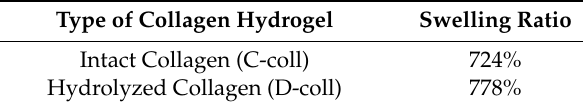
Table 1. Swelling ratio of collagen hydrogel.